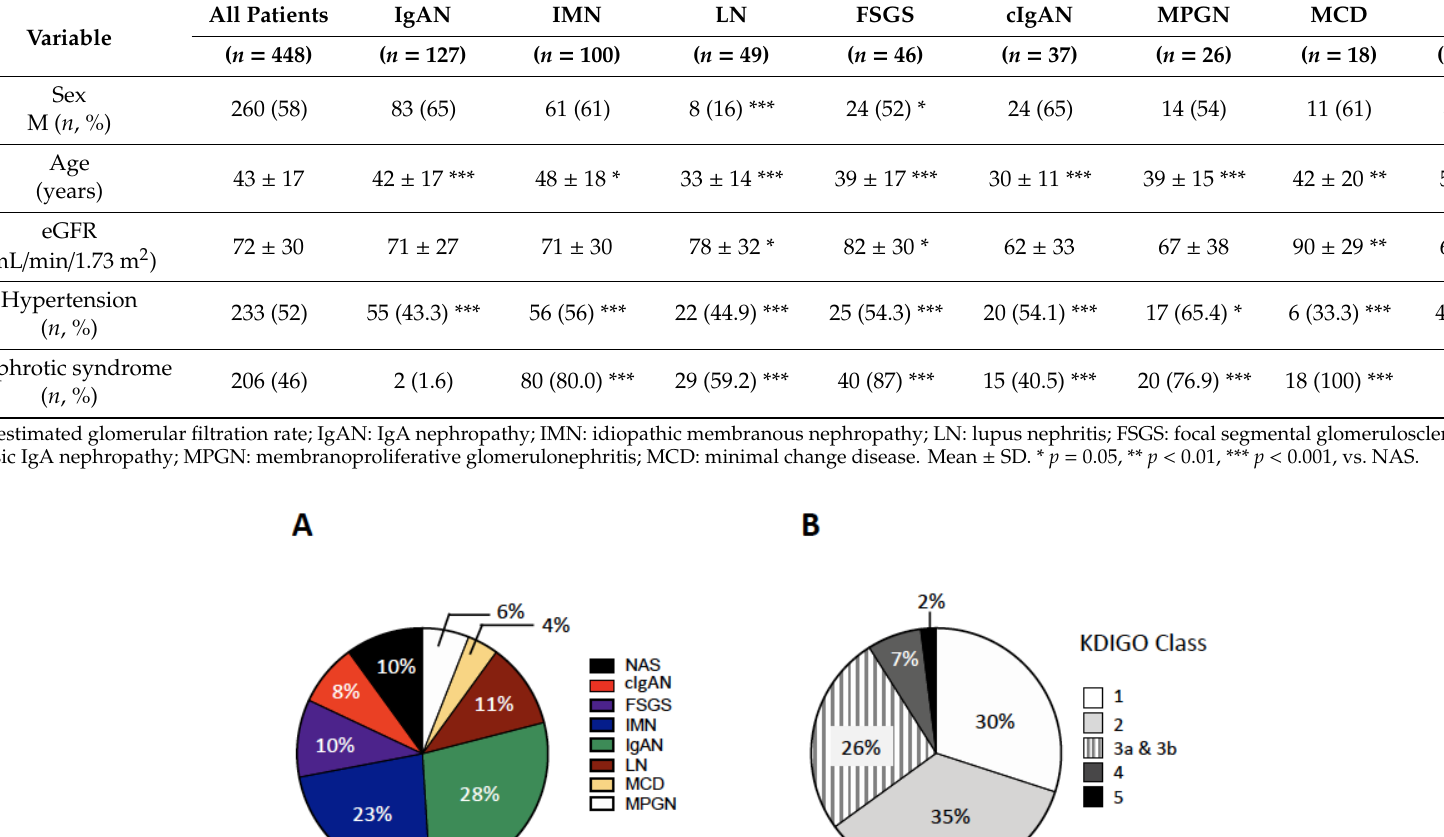
Table 1. Demographic characteristics at baseline of patients with glomerulonephritis (GN) and nephroangiosclerosis (NAS). Variable